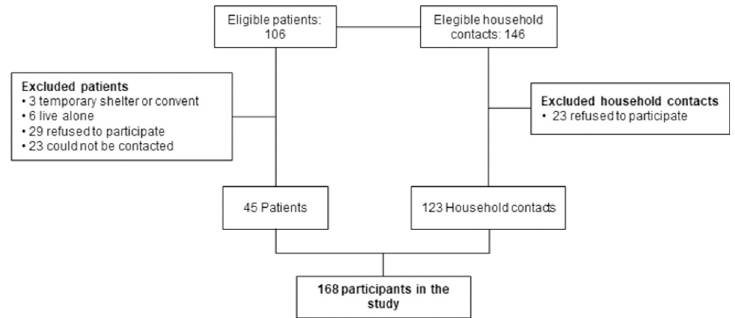
Fig 1. Inclusion of hemodialysis patients and their household